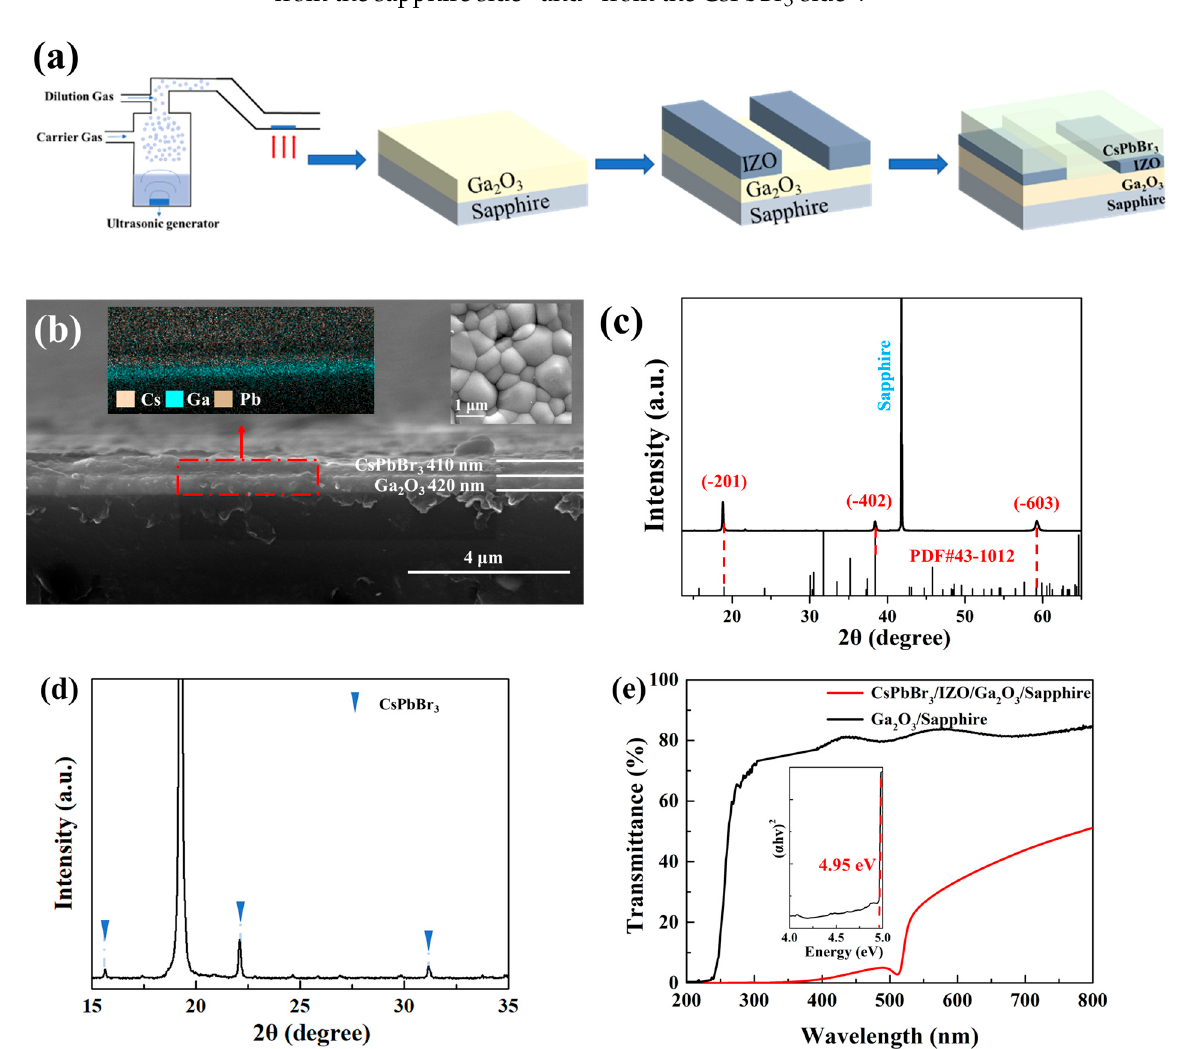
Figure 1. ( a ) The preparation process of the PDs. ( b ) SEM image of the CsPbBr 3 /Ga 2 O 3 /Sapphire film. The inset figures are the EDX (Energy-Dispersive X-ray Spectroscopy) of the cross-section and the SEM of the surface, respectively. ( c , d ) XRD spectra of the CsPbBr 3 /Ga 2 O 3 /Sapphire film. ( e ) UV-vis transmittance spectra of the β -Ga 2 O 3 film and the Ga 2 O 3 /IZO/CsPbBr 3 on sapphire; the inset plot is the ( α h ν ) 2 as a function of photon energy.